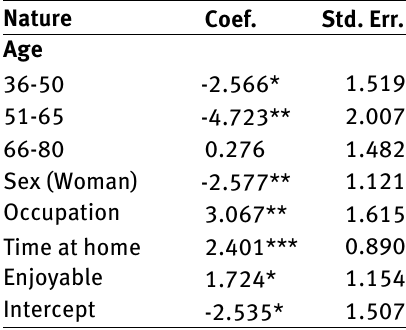
Table 4: Coefficients of the model for nature sounds.